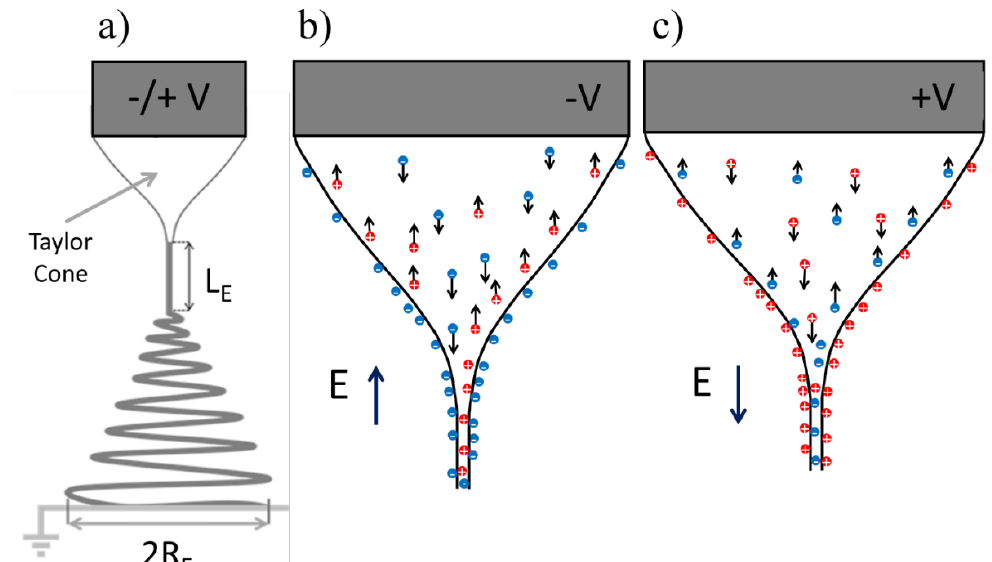
Figure 1. ( a ) A schematic model of the liquid jet during the electrospinning process showing Taylor cone with a straight jet section of length L E , followed by a bending instability region, where R E is the radius of the deposition area. ( b , c ) A schematic of the Taylor cone and jet initiation, showing the charge distribution and ion motion during electrospinning as a function of positive or negative spinneret voltage, where V is the potential, E is the electrical field and red and blue dots represent clouds of positive and negative ions in solution. Black arrows indicate the electrophoretic velocity vectors of the ions.